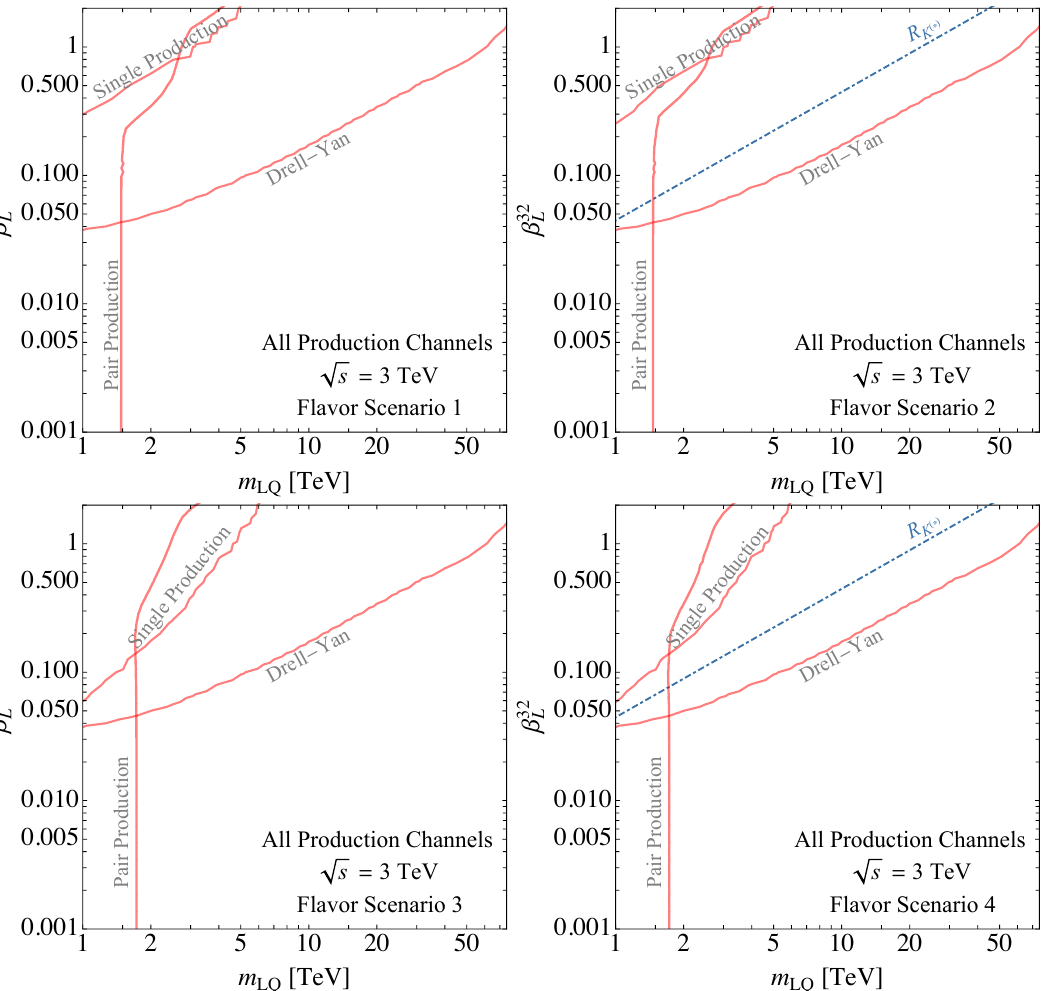
√ Figure 13 . The 5 σ discovery reach of the all channels at s = 3 TeV. Any LQ model in the region to the left or above the red lines can be discovered by the corresponding channel. We show the results for all flavor scenarios presented in table 1. The final state we search for in the scenarios 1 and 2 (3 and 4) is µb ¯ b ( τb ¯ b ). The DY interference bounds are the same across different scenarios, while the single and pair production can change between the scenarios of top or on the bottom row. Additionally, for flavor scenarios 2 and 4, we include the contours corresponding to the central value of the R K anomaly. We find that the parameter space explaining this anomaly is completely covered with our proposed searches. The PP channel can cover the low LQ mass of the parameter space, while the DY interference and single production probing the higher masses; the former can probe LQ masses far beyond the intrinsic reach of the